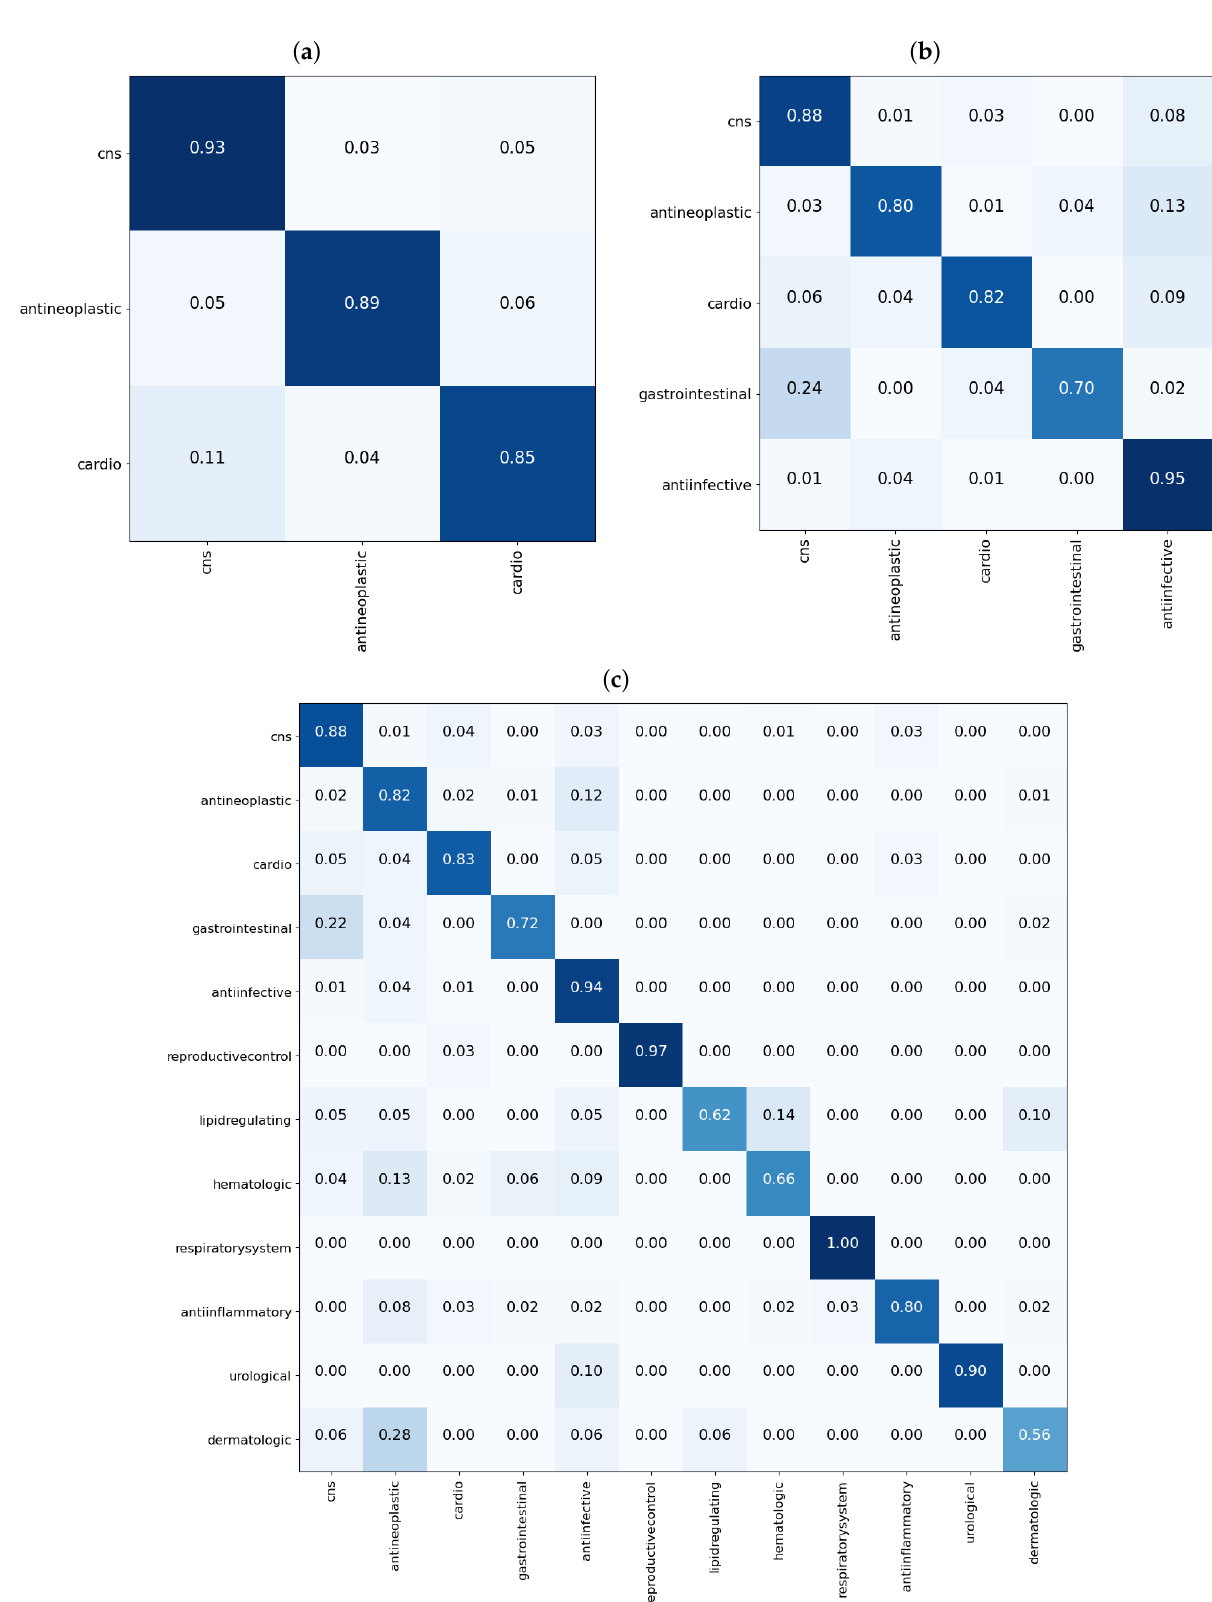
Figure 5. Confusion matrices showing performance of the GCN models on the test data for the single label tasks. In ( a ), results for the 3-task subgroup; in ( b ), results for the 5-task subgroup; and in ( c ), results for the 12-task subgroup. Each matrix shows the proportion of each predicted class, on the x-axis, for molecules in each true class on the